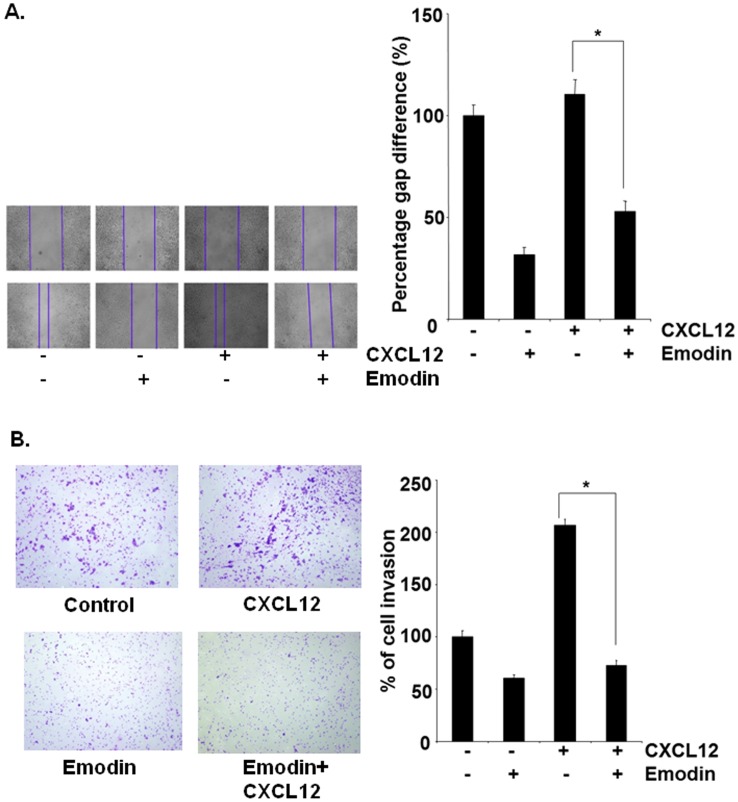
Emodin suppresses migration and invasion of HepG2 cells.A, Wound-healing assay was performed for evaluating the inhibitory effect of emodin on HepG2 cell migration. Confluent monolayers of HepG2 cells were scarred, and repair was monitored microscopically after 12 h of pre-treatment with emodin (50 µM) before being exposed to 100ng/mL CXCL12 for 24 h. Width of wound was measured at time zero and 24 h of incubation with and without emodin in the absence or presence of CXCL12. The representative photographs showed the same area at time zero and after 24 h of incubation. B, HepG2 (2×105 cells) were seeded in the top-chamber of the Matrigel. After pre-incubation with or without emodin (50 µM) for 12 h, transwell chambers were then placed into the wells of a 24-well plate, in which we had added either the basal medium only or basal medium containing 100 ng/mL CXCL12 for 24 h. After incubation, they were assessed for cell invasion as described in Materials and Methods. Columns represent percentage of invaded cells; bars, S.E. *indicates p value <0.05. Representative results of two independent experiments are shown.